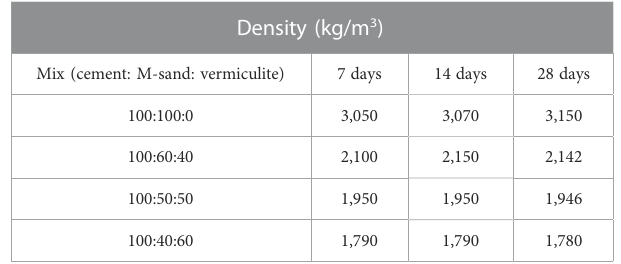
TABLE 4 Density results.